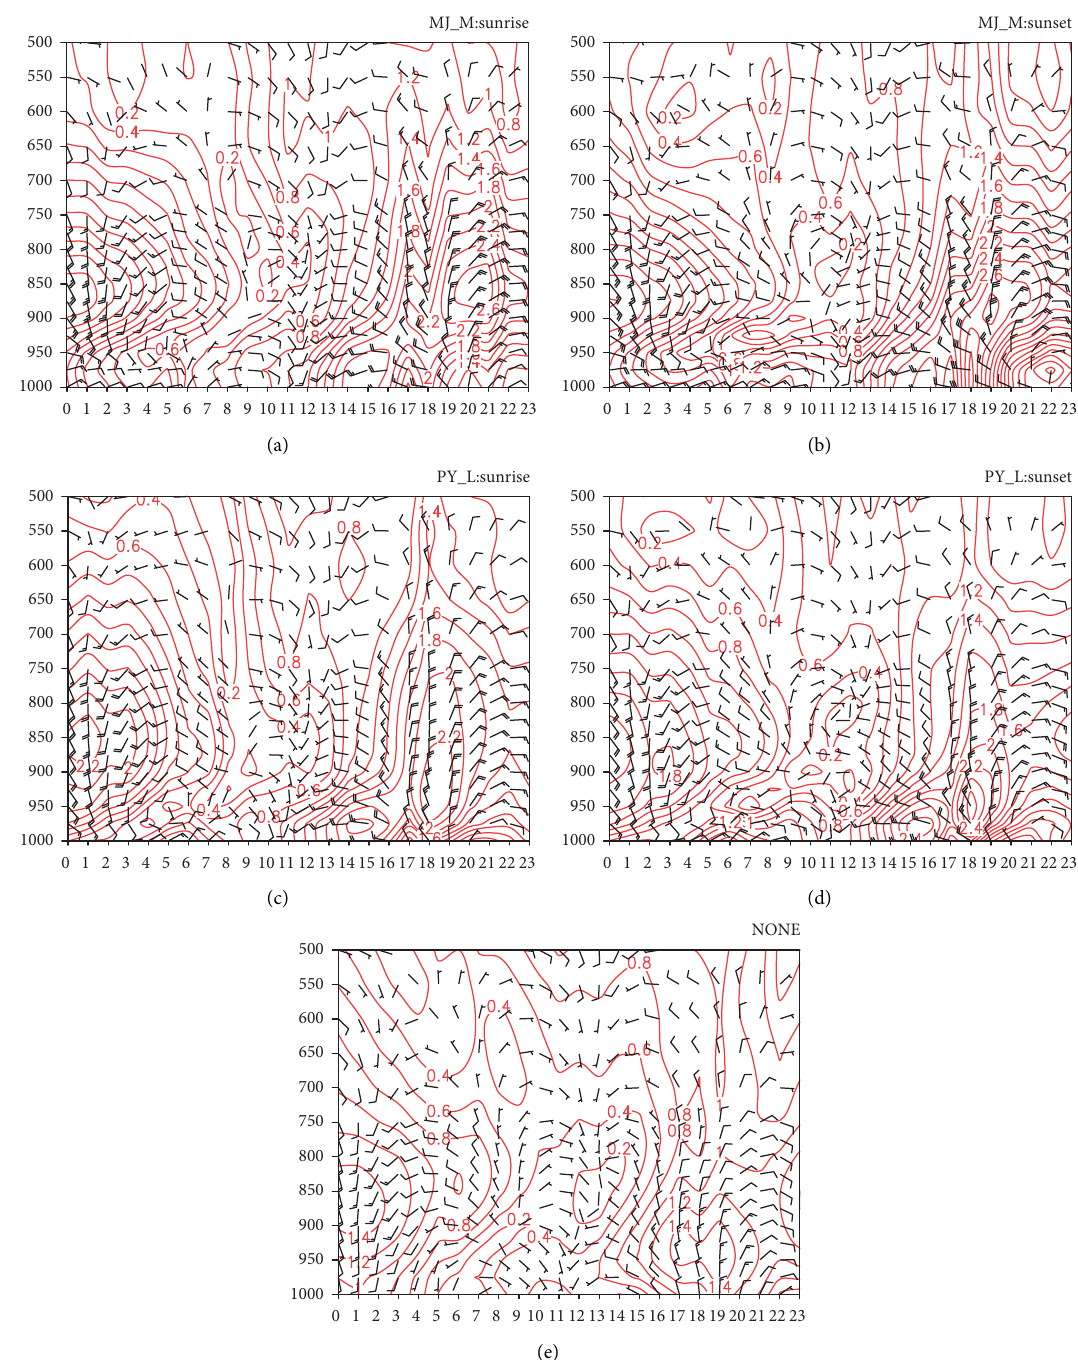
Figure 10: Te diurnal variation (hourly value minus daily average value) of the ageostrophic wind when HHR occurs at sunrise or sunset in each region (Figure 10a-d) and the diurnal variation of the ageostrophic wind on non-HHR days (Figure 10e). Te regional average range of Figure 10e is (27 ° N–32 ° N, 110 ° E–118 ° E), and the regional average range of other fgures is marked in the upper right corner. Te contour line represents the wind speed, and one bar of wind bar is 1